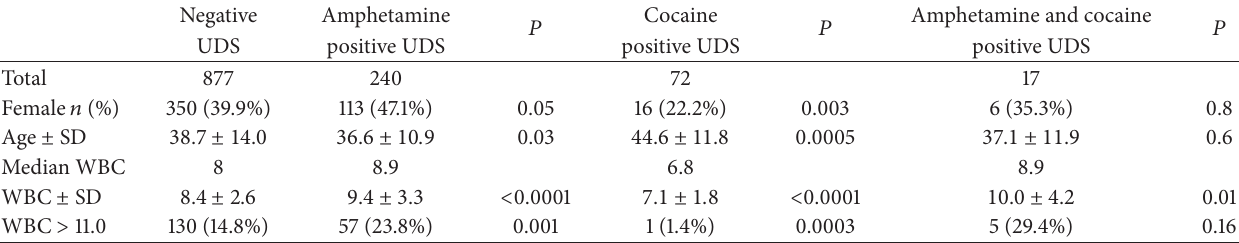
Table 2: Differences between amphetamine and/or cocaine urine drug screen (UDS) positive and negative